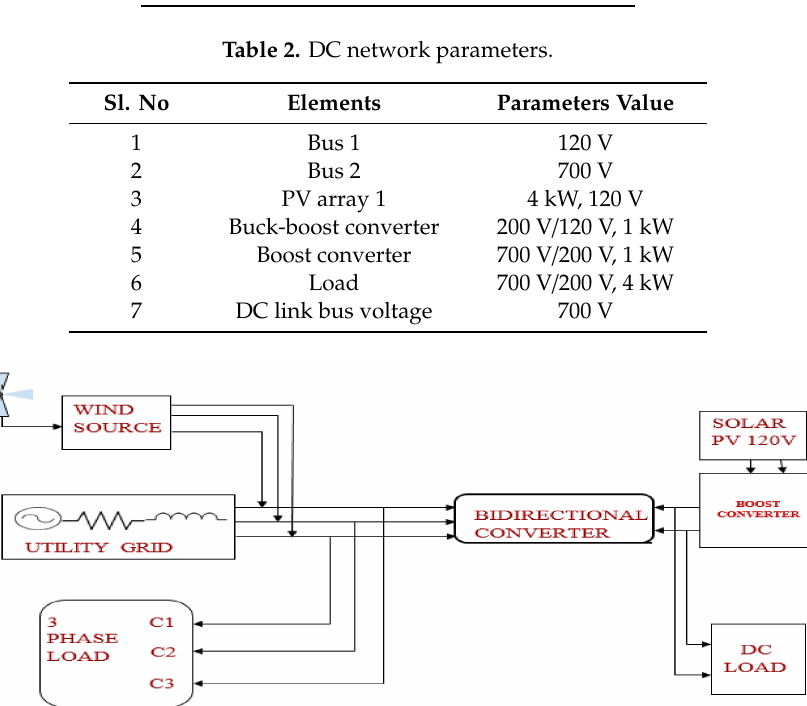
Figure 4. Hybrid photovoltaic / wind (AC / DC) microgrid system in MATLAB Simulink